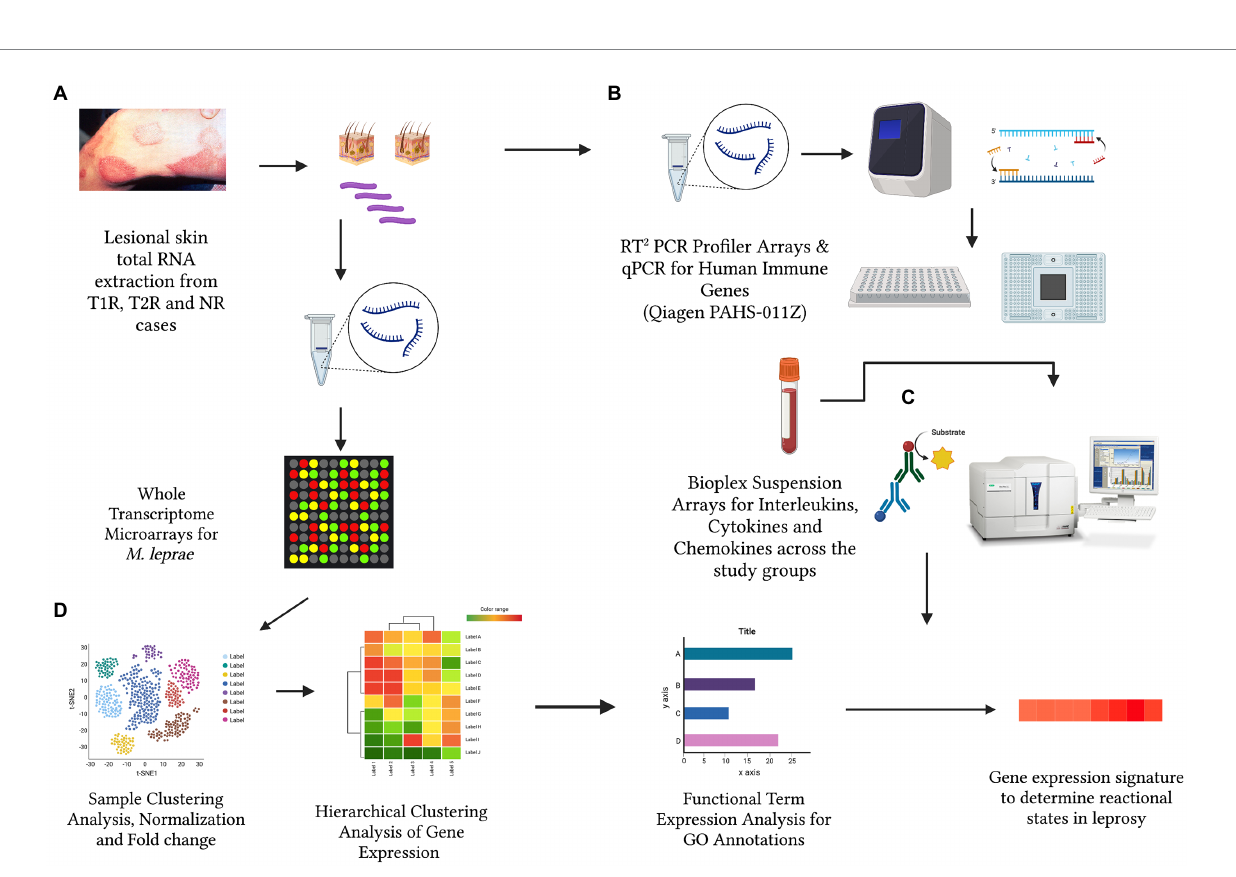
FIGURE 1 The schematic representation for the cross-sectional analysis of Mycobacterium leprae transcriptome (A) , human immune gene expression (B) and corresponding circulatory levels of cytokines, interleukins and chemokines (C) to derive a gene expression signature for reactional states of leprosy (D) . (Created with